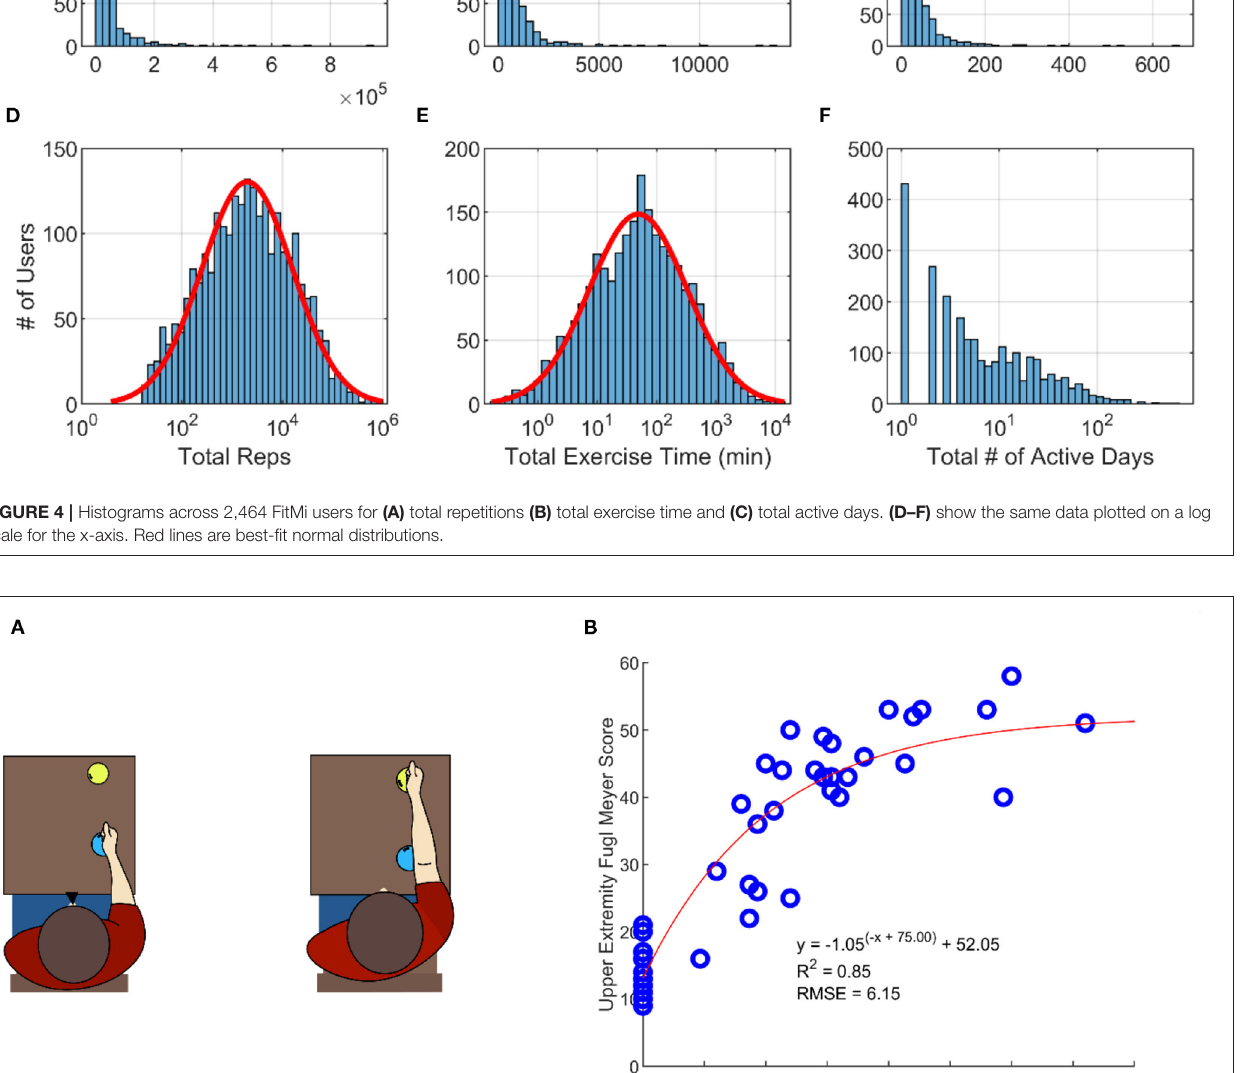
of exercise initiation associated with the probability of perseverance, although the relationship was relatively flat in the intermediate